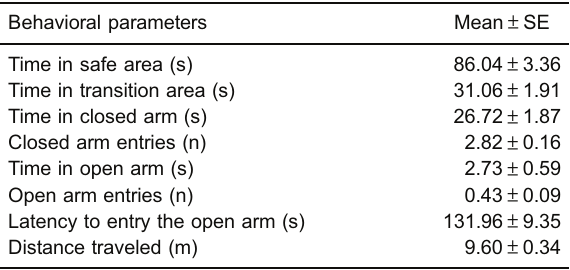
Table 4. Description of the behavioral pro fi le of the rats exposed to elevated gradient of aversion test for 3 min. Behavioral